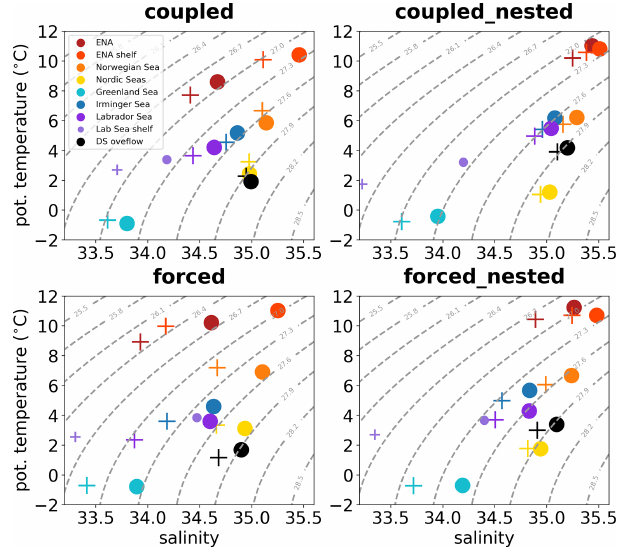
Figure 9. Mean water properties of regions depicted in Fig. 8 (same color coding) from the reference simulation (filled circles) and the perturbation experiment (“plus” symbols). Symbols depict proper- ties averaged over the upper 200m, except for the Denmark Strait (DS) overflow (in black) where values from the deepest grid cells (approx. 600m depth) along the section at about 65.7 ◦ N are aver- aged. For the Labrador Sea region (purple), properties on the con- tinental shelf (smaller symbols) are shown in addition to the ones from the interior part (regular-sized symbols). The shelf is defined as areas shallower than 500m in the region 62–46 ◦ W and 56– 65 ◦ N, i.e., within the same geographical box as the deep, interior Labrador Sea (purple frame in Fig.